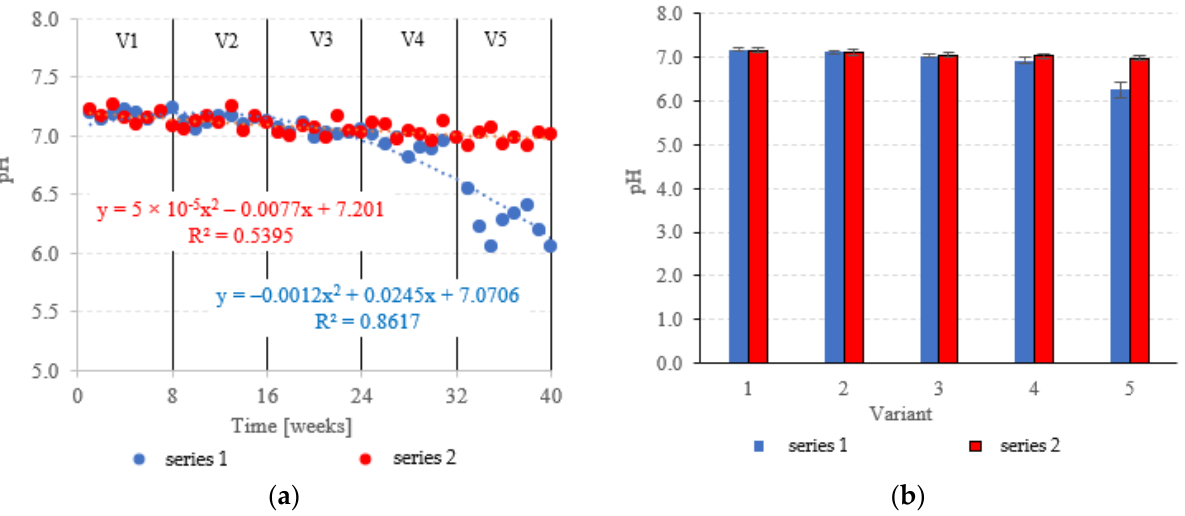
Figure 13. pH in the anaerobic reactors (( a ) changes throughout the experiment; ( b ) average across experimental variants).